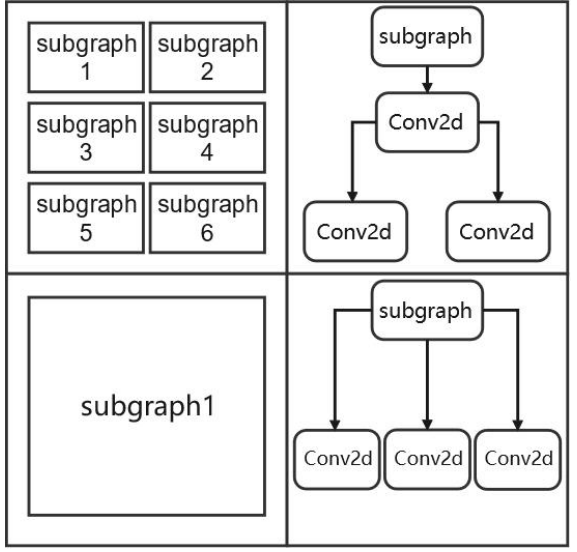
Figure 10. An inference framework for deploying the network model on the hardware.